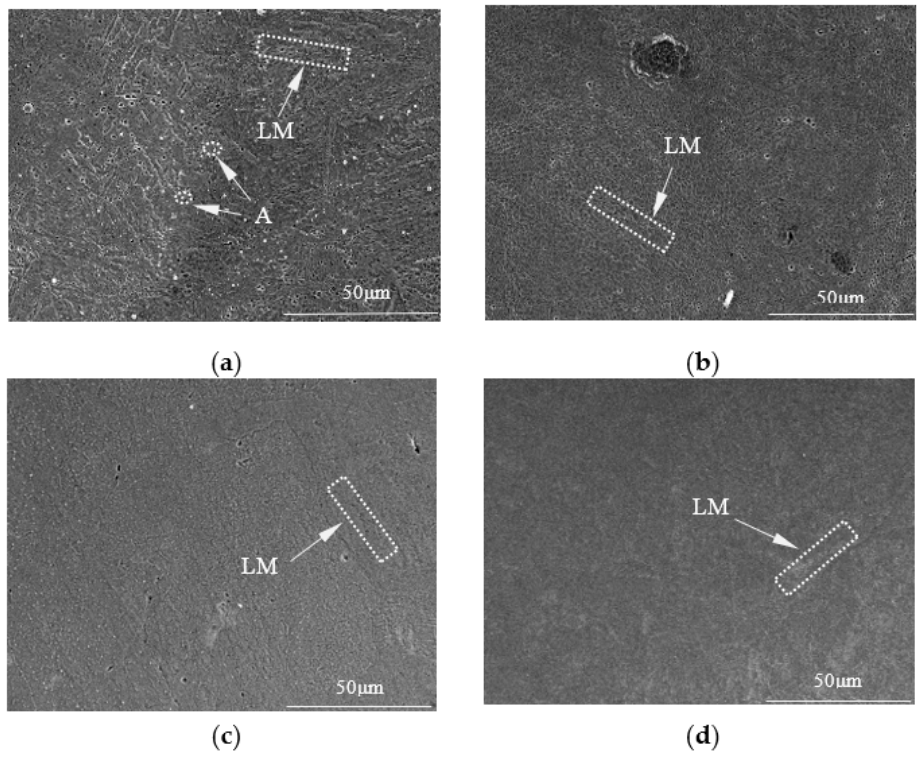
Figure 8. Microstructure of the DP590-304 welded joints fusion zone: ( a ) Sample 1; ( b ) Sample 2; ( c ) Sample 3; ( d ) Sample 4.